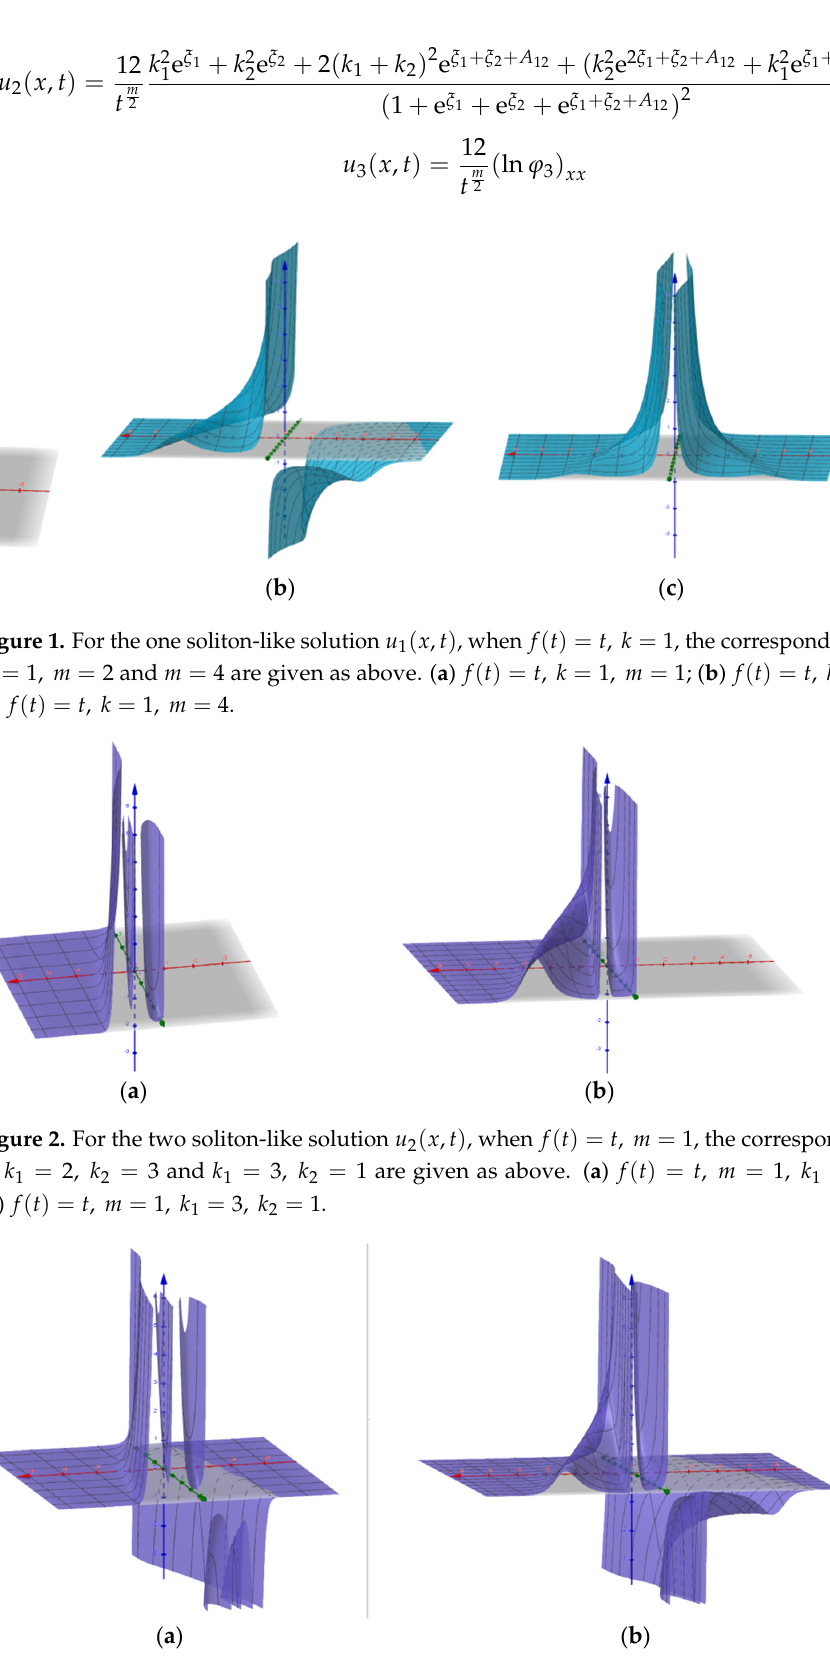
Figure 3. For the two soliton-like solution u 2 ( x , t ) , when f ( t ) = t , m = 2, the corresponding figures of k 1 = 2, k 2 = 3 and k 1 = 3, k 2 = 1 are given as above. ( a ) f ( t ) = t , m = 2, k 1 = 2, k 2 =